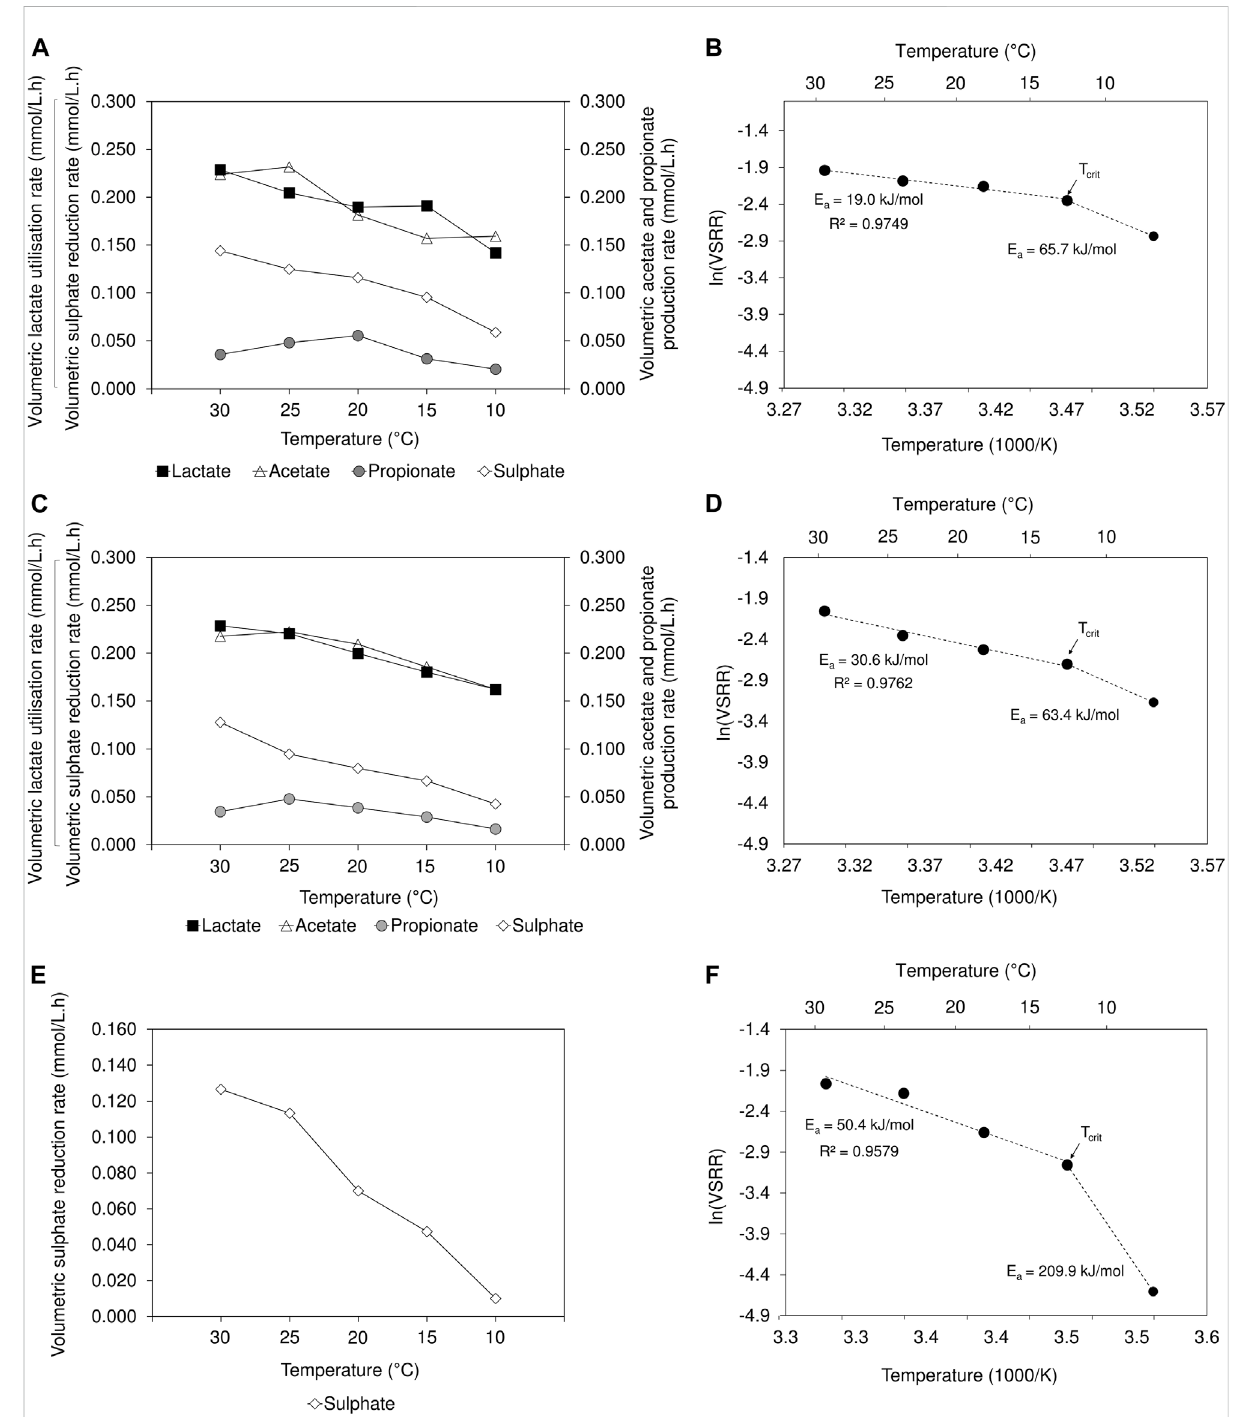
FIGURE 3 Temperature dependency on VSRR, VFA utilisation/production rates in the (A) 2 L lactate-fed, (C) 8 L lactate-fed and (E) 2 L acetate-fed reactors. Arrhenius plots showing temperature dependency of VSRR, showing the E a values for the linear range between 30 and 15 ° C as well as the deviation at 10 ° C in the (B) 2 L lactate-fed (D) 8 L lactate-fed and (F) 2 L acetate-fed reactor. The indicated T crit represents the critical temperature, below which microbial activity is signi fi cantly